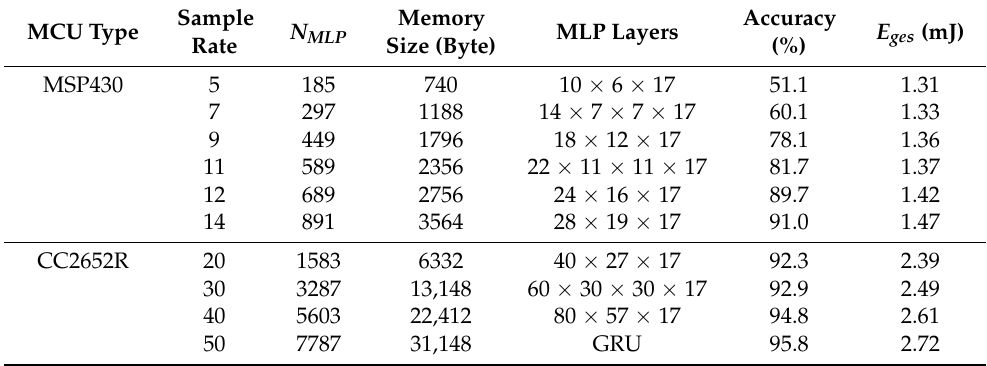
Table 3. Details of the Pareto Front design